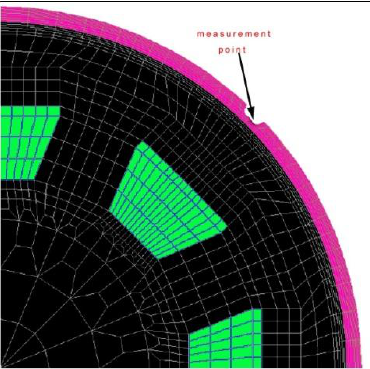
Figure 13. The measurement point used for a central defect, for a 0.625 inch thick, 30 inches OD pipe. The measurement position is 8 mm from the inside of the pipe wall.